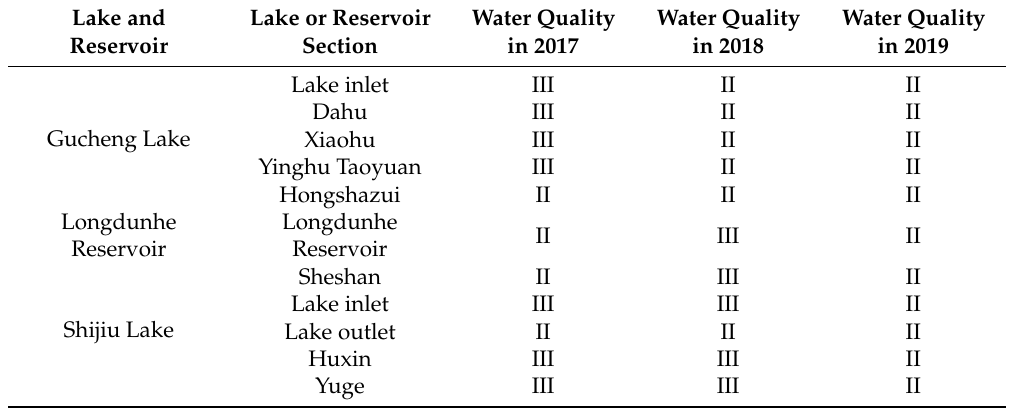
Table 2. 2017–2019 Gaochun District Reservoir and Lake Water Quality